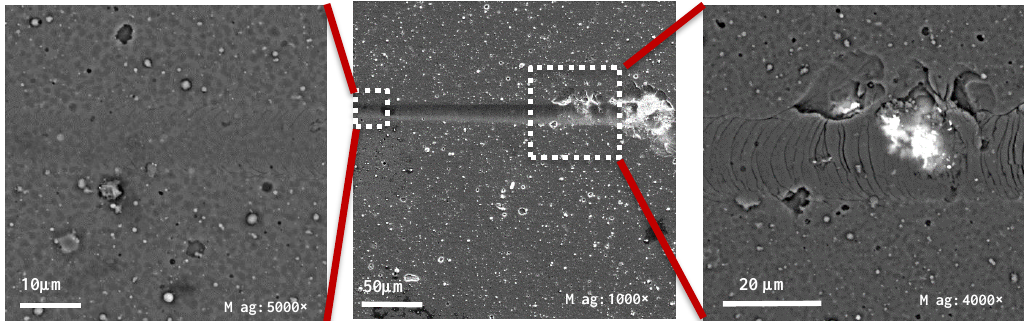
Figure 6. SEM images of a micro-scratch test on the 3 µm bi-multilayer, with higher magnification images of the deformation at the L c 1 and L c 2 failures.